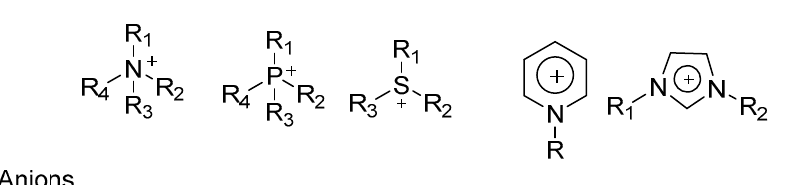
Figure 28. Structure of ionic liquids used for Heck reaction reviewed by Sheldon [101].